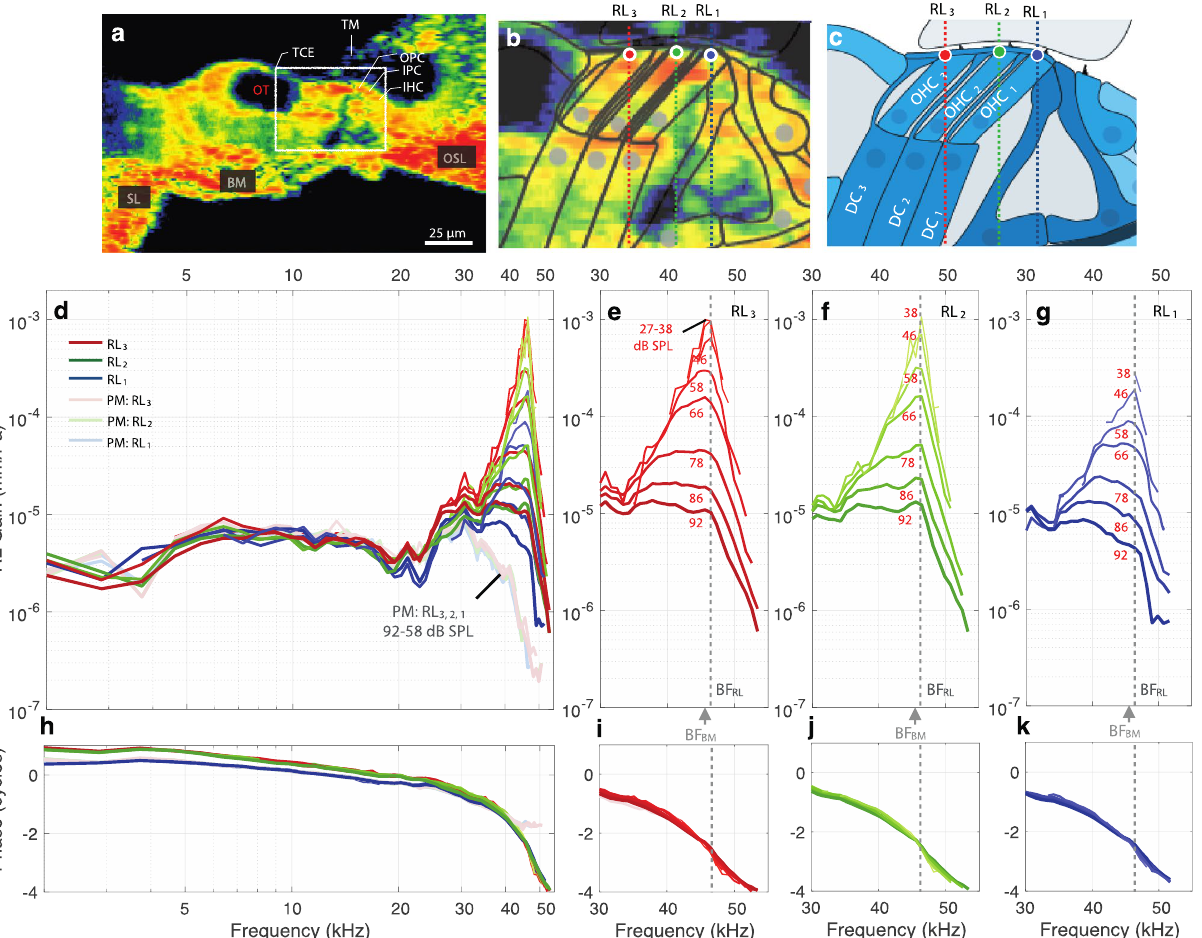
Figure 3. The in vivo and PM RL Gains across the apical ends of the three rows of OHCs (RL 3 , RL 2 , RL 1 ) from gerbil G637. ( a ) A 2D cross-sectional OCT image of a representative in vivo gerbil OoC with labeled key structures. Note that the OoC structure is displayed upside down in comparison to Fig. 1. ( b ) An enlargement of the region in panel a within the white box, with overlaid line drawings of the cells and other structures, and details of the measurement locations across the apical ends of the three rows of OHCs (RL 3 , red circle; RL 2 , green circle; and RL 1 , blue circle). Each colored vertical line indicates the lateral position and direction of the different OCT A-scans for the OCT vibrometry measurements. ( c ) A labeled cross-sectional drawing from the 2D OCT image in panel ( b ). ( d ) In vivo (dark red/green/blue) and PM (faded red/green/blue) gains for RL 3 , RL 2 , and RL 1 , respectively. ( e – g ) The in vivo, active-amplification region showing RL 3 , RL 2 , and RL 1 gains, respectively. The gains were highest at low SPLs. The numbers in panels ( e – g ) indicate the stimulus level for each gain response (in panel e the curves overlap for 27–38 dB SPL ) . ( h – k ) The phase responses corresponding to panels ( d – g ). In this figure the displacements were normalized by the sound pressure to produce gains in units of mm/Pa, and the phase responses are in units of cycles. The frequency axis is on a log scale in panels ( d ) and ( h ), but on a linear scale in panels ( e – g ) and ( i–k ). ( b ) Overlaid line drawings and ( c ) cartoon drawing by Andrew A. (Fig. 6a), but the BM APJ gain decreased faster so that above BF RL the OHC-DC-junction gain was greater than the high-level BM APJ gain (above BF RL the lines go up in Fig. 6b). The phases of the OHC-DC-junction gains were similar across the three rows at mid frequencies, but the phases deviated from each other at high and low frequencies (Fig. 6c, b). At mid frequencies the OHC-DC- junction phases lagged behind the high-level BM APJ phase and the OHC-DC-junction phase of the dead animal by ~ 0.25 cycles (Fig. 6d). At the lowest frequencies, the lags in the OHC-DC-junction phase approached zero (Fig. 6d). Near the BM APJ BF (BF BM ), the OHC-DC-junction 3 phase lagged behind the high-level BM APJ phase by ~ 0.25 cycles, with rows 1 and 2 lagging more. The gains and phases at selected frequencies are shown for all animals in Fig. 7. The OHC-DC-junction data varied relatively little across animals, and the observations for the example animal (G637) generally held across all animals (Fig. 7).